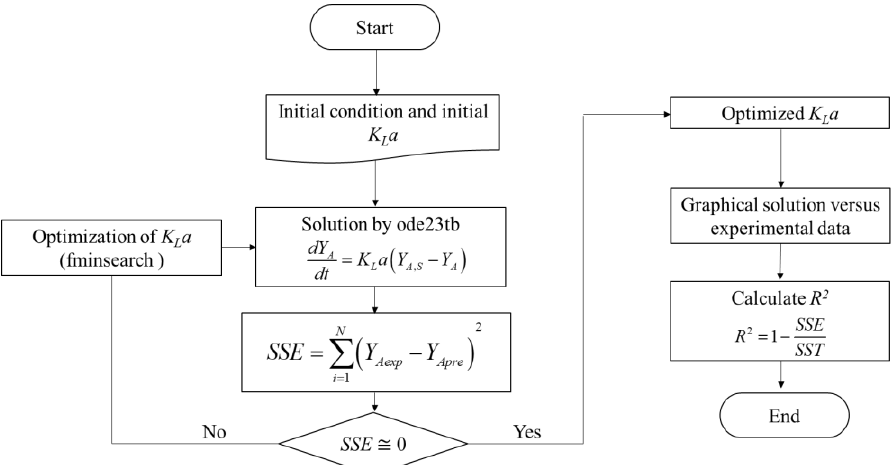
Figure 6. Optimization algorithm for the solution of the differential equation and the estimation of K L a 𝐾 𝐿 𝑎 .